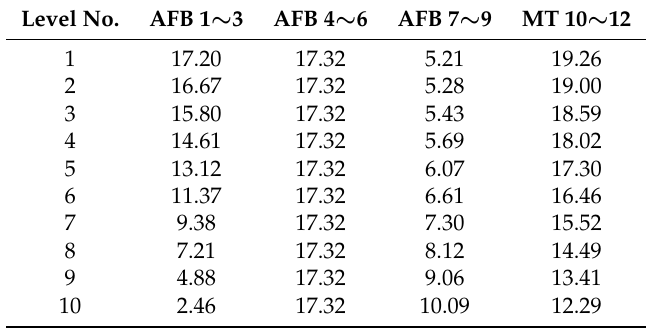
Table 2. The pre-stressed length of the cytoskeletal components, with the unit of µm. Level No.